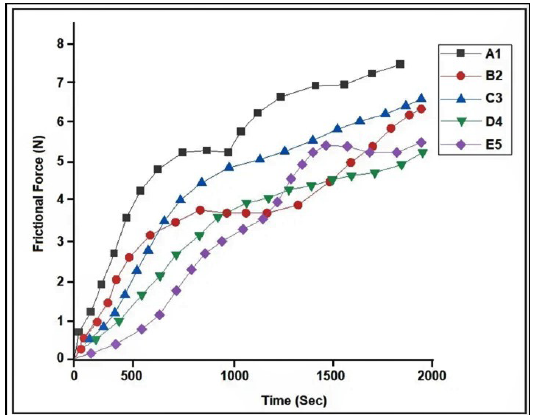
Figure 6. Coefficient of friction at 1m/s sliding